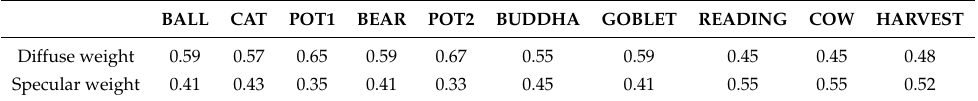
Figure 10. Left: Diffuse weight for diffuse and metallic samples in the CyclesPS dataset. The vertical coordinate represents the value of the reflectance weight. The horizontal coordinate represents the names of the objects in the CyclesPS dataset. The objects marked with ∗ are visualized in the diagram on the right. Right: Six objects from the CyclesPS dataset. Each example consists of a normal map, an image of a diffuse sample, and an image of a specular sample. Table 2. The average weights ( w azi + w ele ) of 10 objects in the DiLiGenT 2